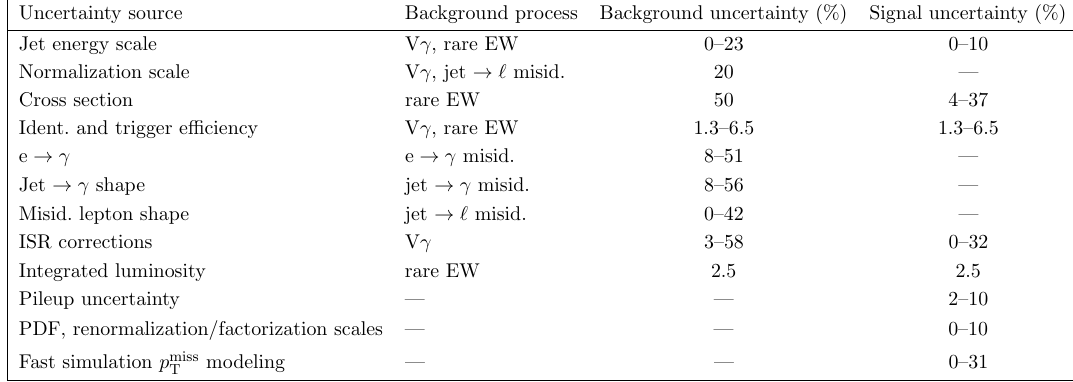
Table 1 . The relative systematic uncertainties in the SM background processes (third column) and the expected SUSY signal (fourth column). The ranges refer to the uncertainties over the di(cid:11)erent kinematic